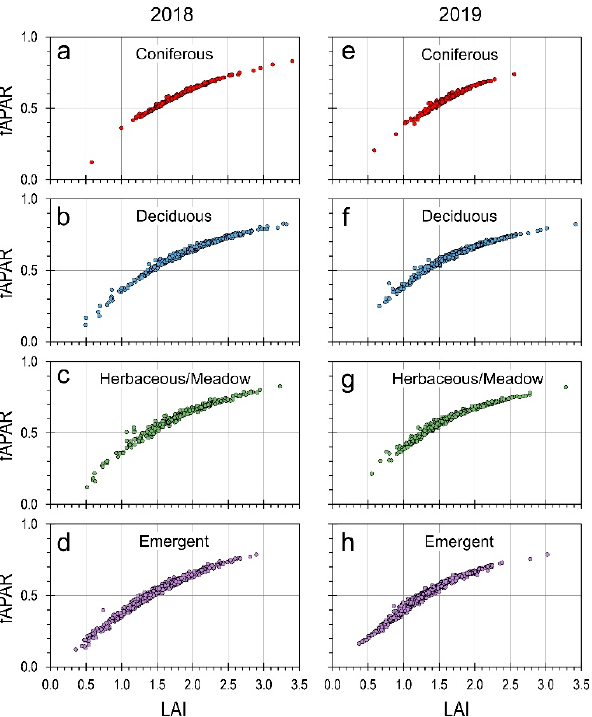
Figure 14. July comparison of absorbed fAPAR vs. LAI for the 2018 ( a – d ) and 2019 ( e – h ) for the Coniferous, Deciduous, Herbaceous/Meadow and Emergent classes. See Figure 13 for definition of acronyms.